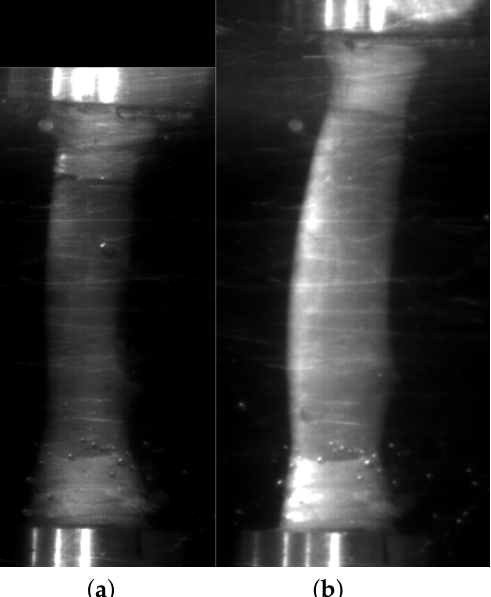
Figure 5. Experimental assembly. ( a ) Unstretched thoracic aorta ( b ) Pressurized thoracic aorta with a